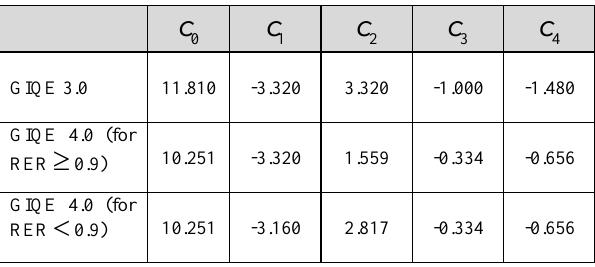
Table 4. Coefficient by GIQE version